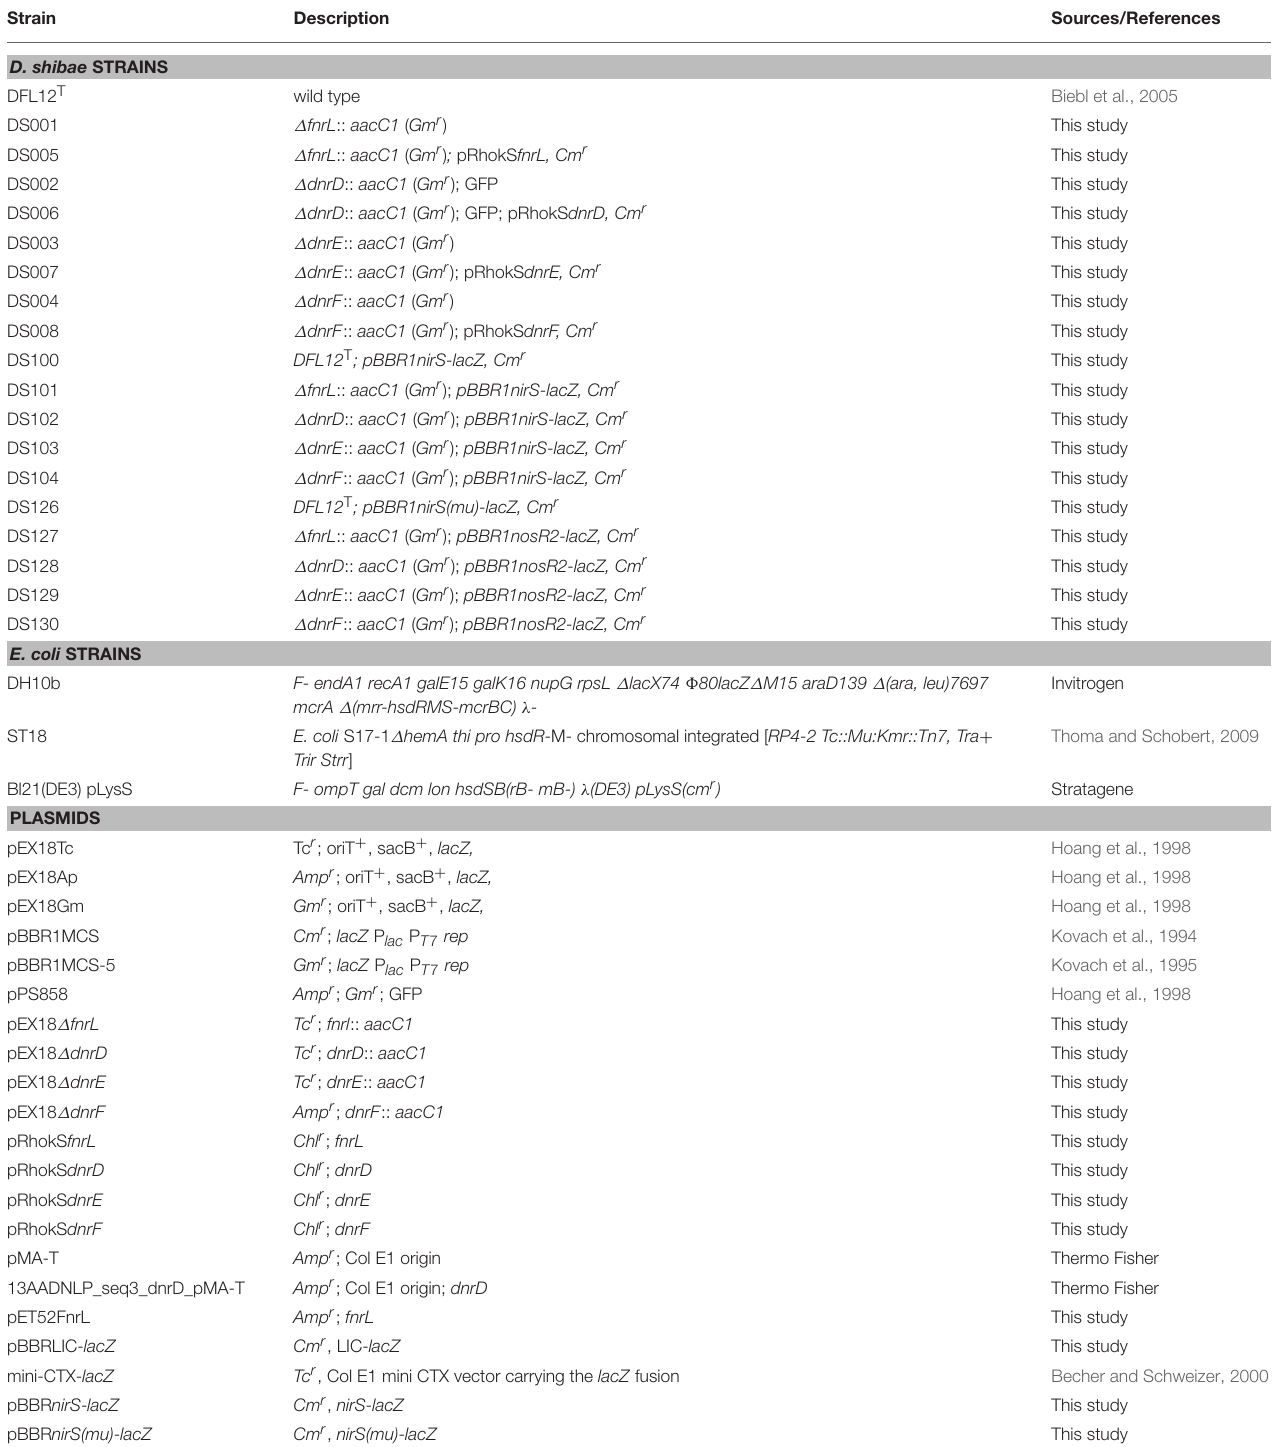
TABLE 1 | Strains and plasmids used in this study.